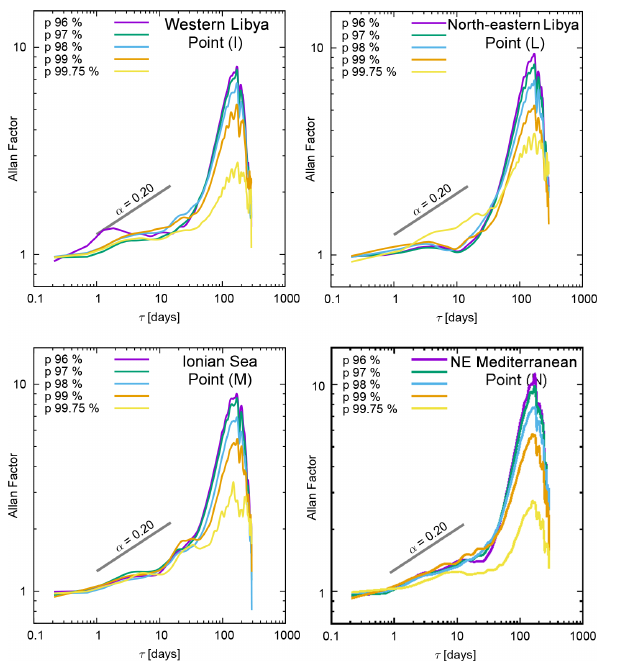
Figure 10. Allan factor (AF) as a function of counting window τ and of the wave height threshold (different percentiles as in the leg- end) for different locations in the Mediterranean Sea (cf. Fig. 2).